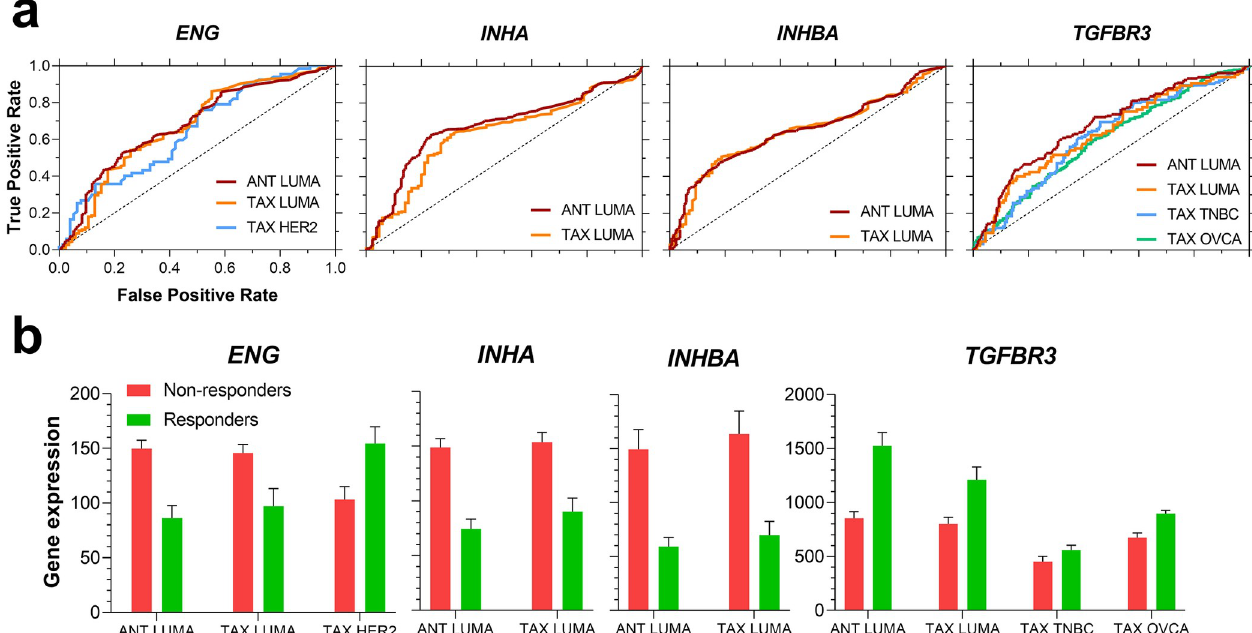
Fig 4. ROC plots (a) and gene expression (b) of indicated genes for different chemotherapy regimens. (a) ROC curves, in which performance ability was verified (i.e., AUC > 0.6), were plotted for ENG , INHA , INHBA , and TGFBR3 . (b) Gene expression for each investigated gene between responders and non- responders for the assessed pharmacological treatments. The sample sizes for each group were the following: ANT LUMA, n = 474; TAX LUMA, n = 375; TAX HER2, n = 143; TAX TNBC, n = 290; TAX OVCA, n = 851. Abbreviations: ANT: anthracycline; TAX: taxane; LUMA: luminal A; TNBC: triple-negative breast cancer; OVCA: serous ovarian